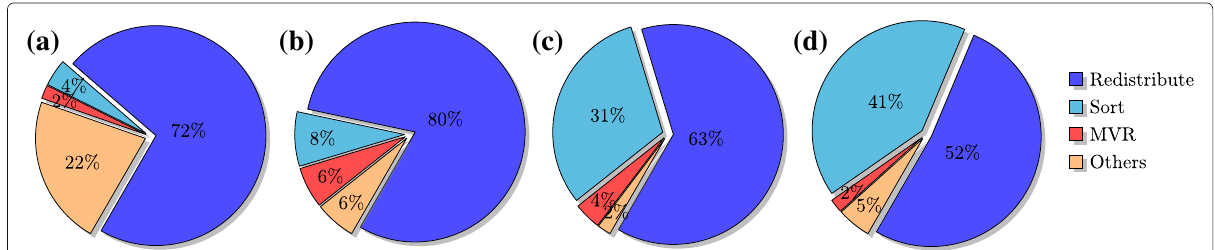
Fig. 8 Overall runtime profile of the particle filtering algorithm for the following implementations: a Sequential. b Hadoop. c Spark with 2 17 particles. d Spark with 2 20